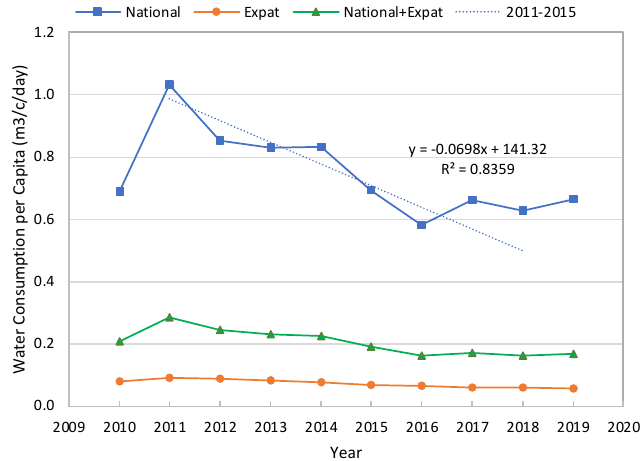
Figure 7. The water consumption per capita for national and expat residential category (2010– 2019).